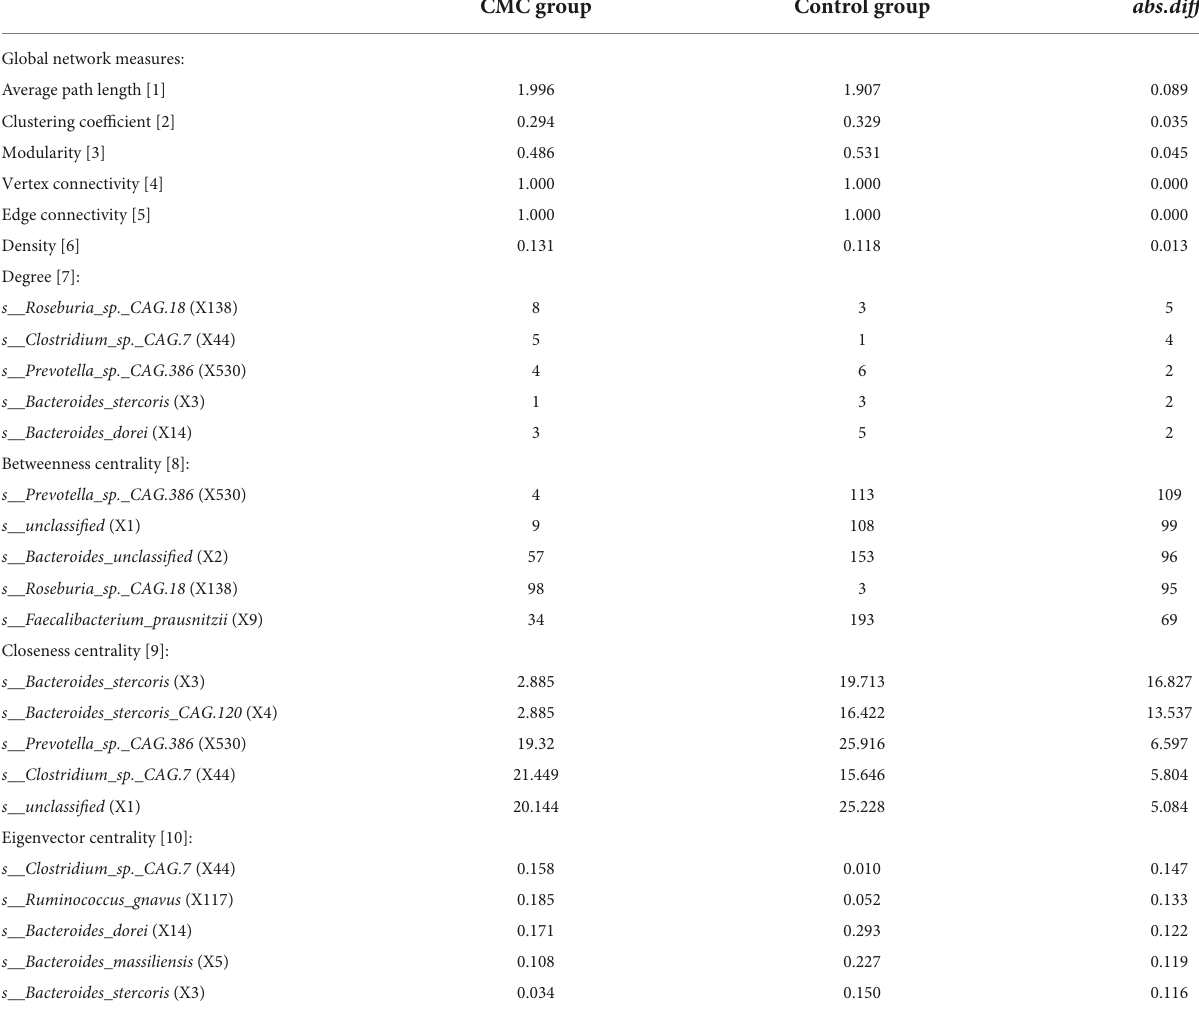
TABLE 6 Results from testing global network metrics and centrality measures of the networks in Figure 5B . CMC group Control group